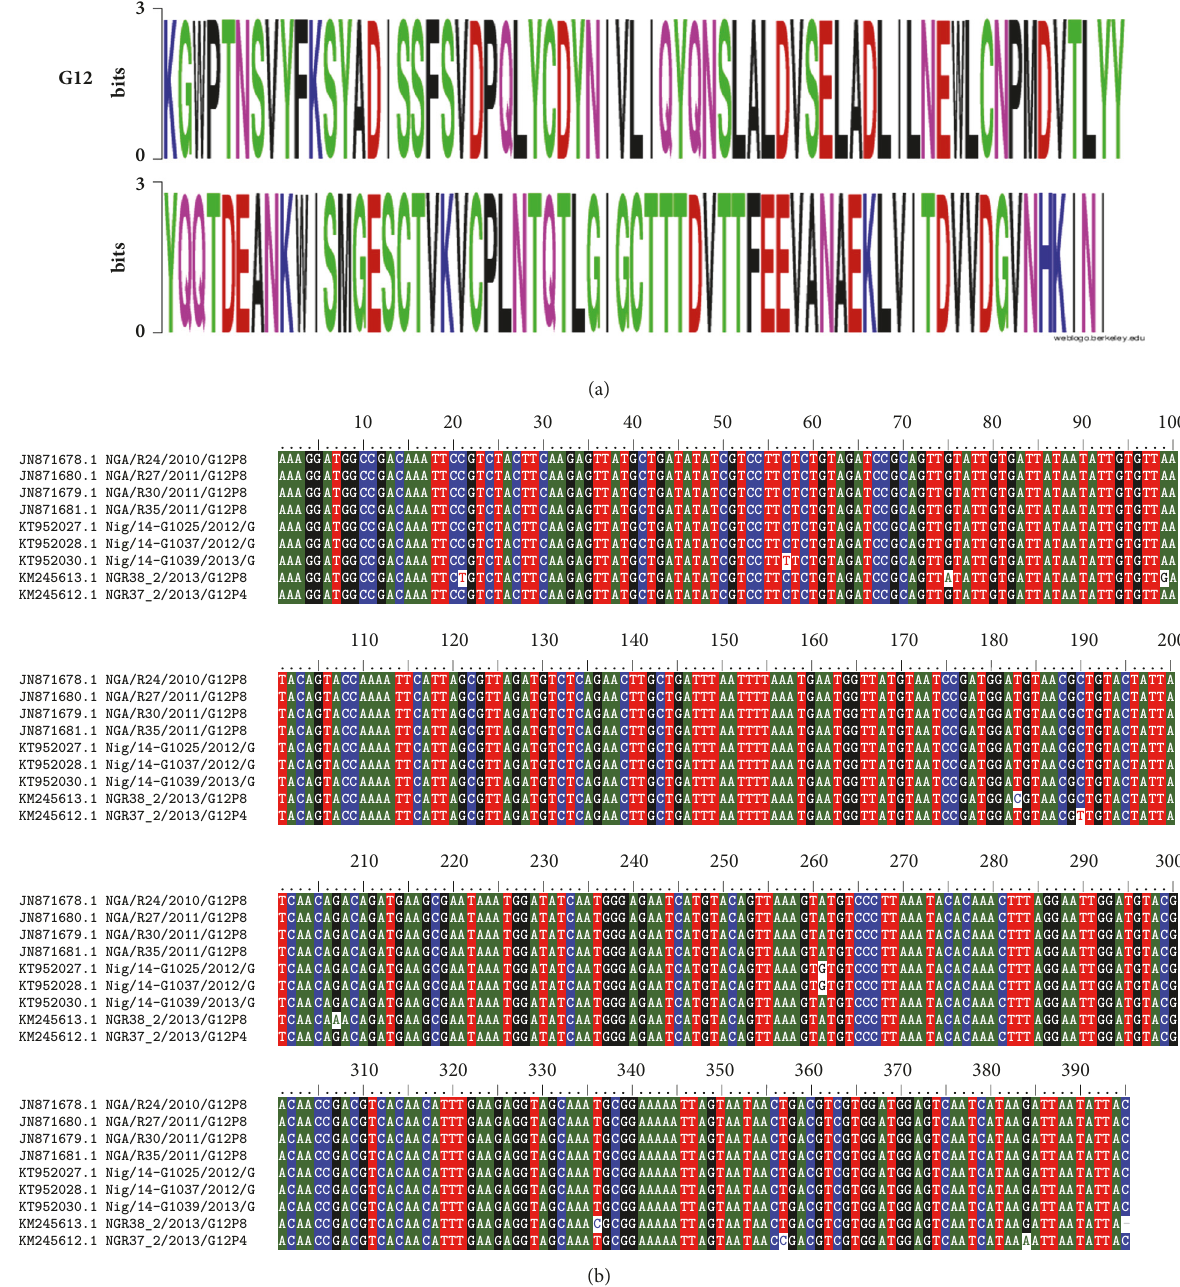
Figure 2: (a) Alignment of amino acid motifs from positions 112 through 243 of rotavirus group A (VP7), G12 sequences from Nigeria, showing relative abundance of individual amino acid at each position analyzed. The bit size of each amino acid is directly related to the frequency of its presence in the alignment. (b) Nucleotide sequence alignment of the 395bp region codding for the partial VP7 gene corresponding to the amino acid position 112 through 243